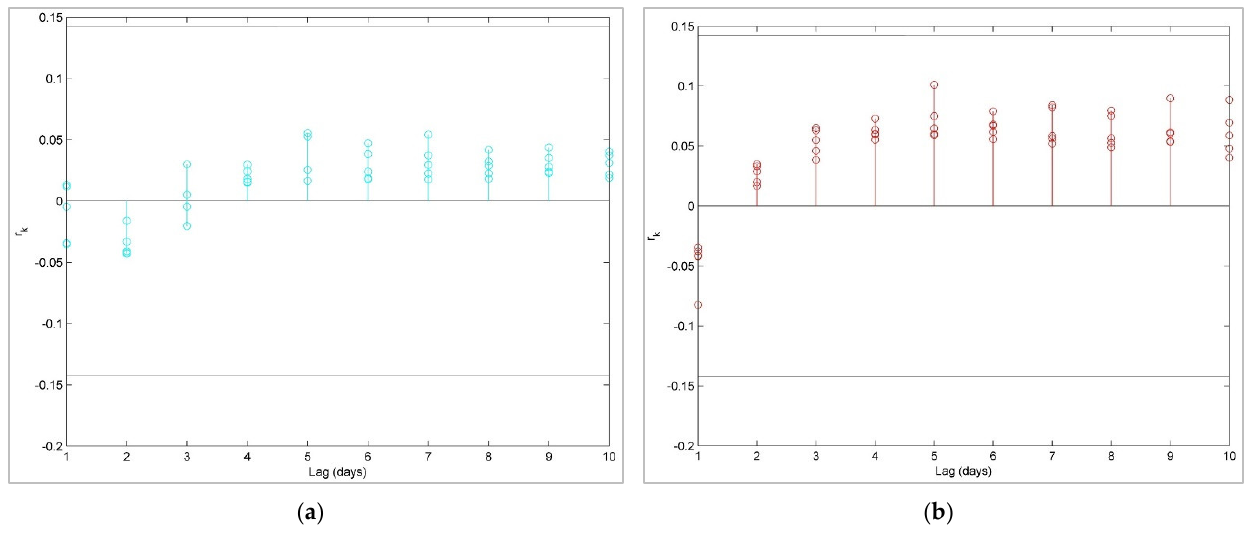
Figure A5. Daily correlation function for residual series considering the ten lag days: ( a ) Model 1 (M1) and ( b ) Model 2 (M2).